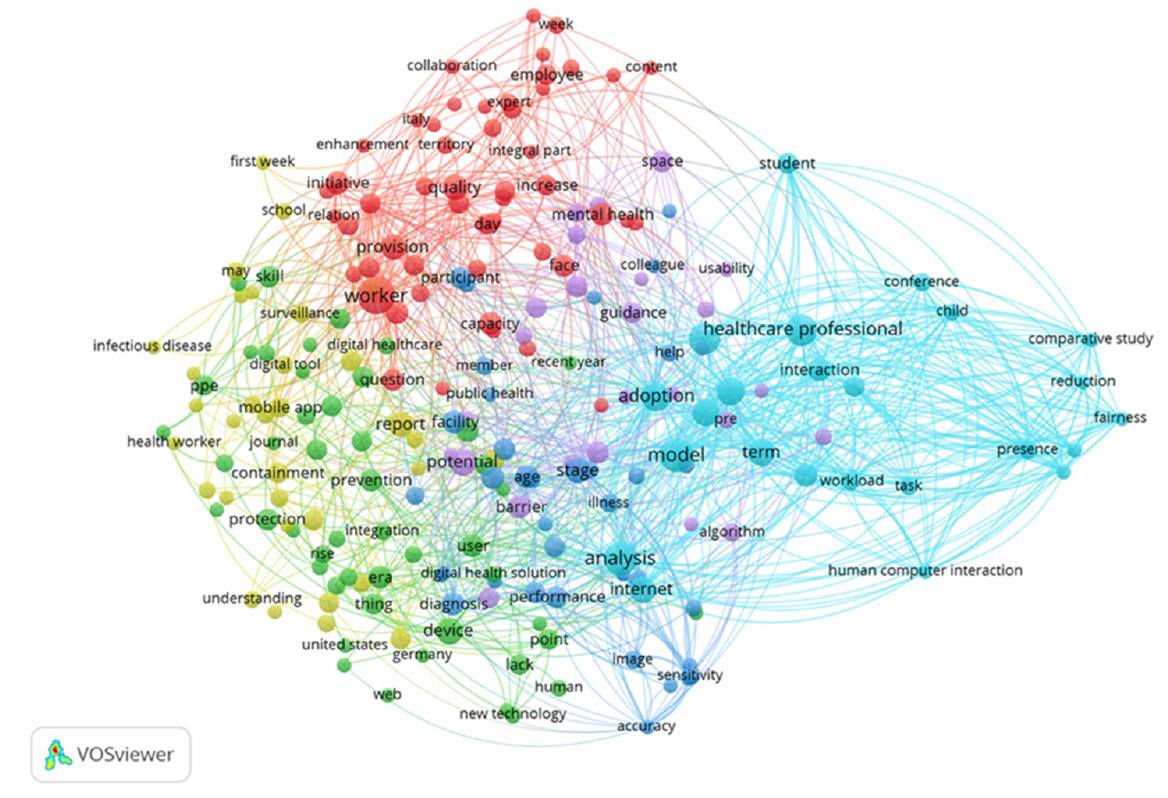
Figure 11. The cluster view of the keyword network on digital healthcare in COVID-19 pandemic.